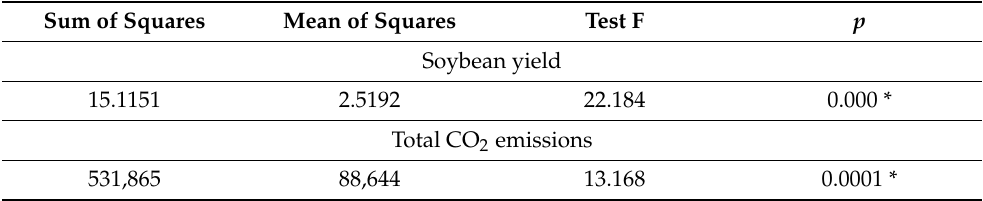
Table 6. Results of the analysis of variance in single classification: soybean yield and total CO 2 emissions depending on the doses of biochar applied to the